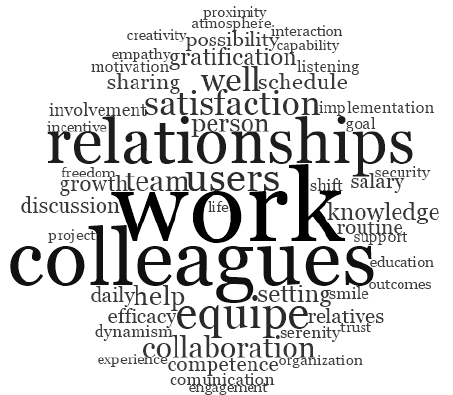
Figure 1. Words used to describe the three protective factors of well-being at work.